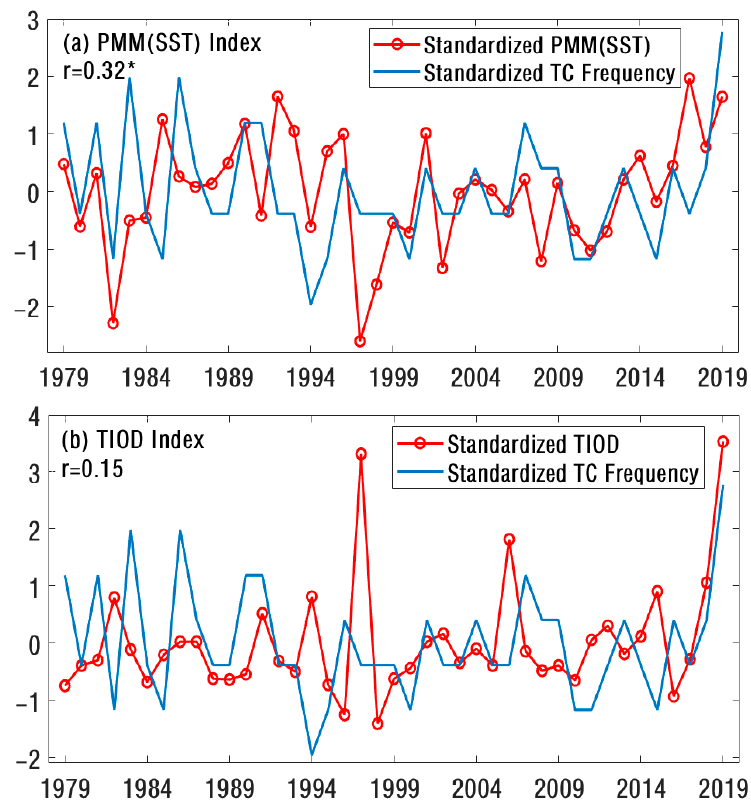
Figure 9. Standardized time series of TC frequency and Pacific meridional mode (PMM) index ( a ), and tropical Indian Ocean Dipole (TIOD) index ( b ) in the Novembers of 1979–2019. Correlation coefficients are also shown, with the sign “*” indicating a significant value at a 95% confidence level.